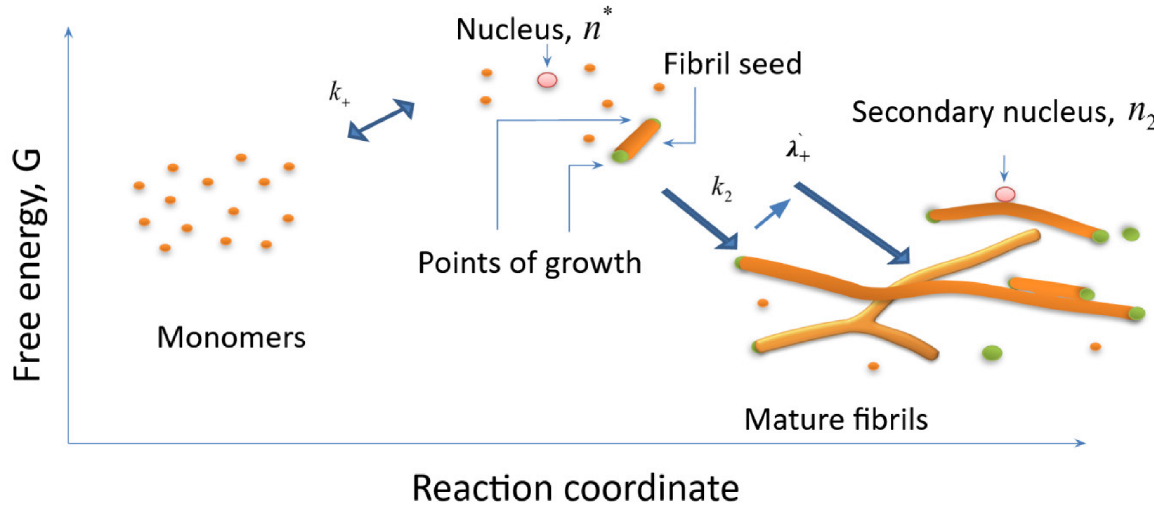
Figure 2. Free energy change during initiation and subsequent exponential fibril growth in the case of branching scenario, n * is the primary nucleus size, n 2 is the secondary nucleus